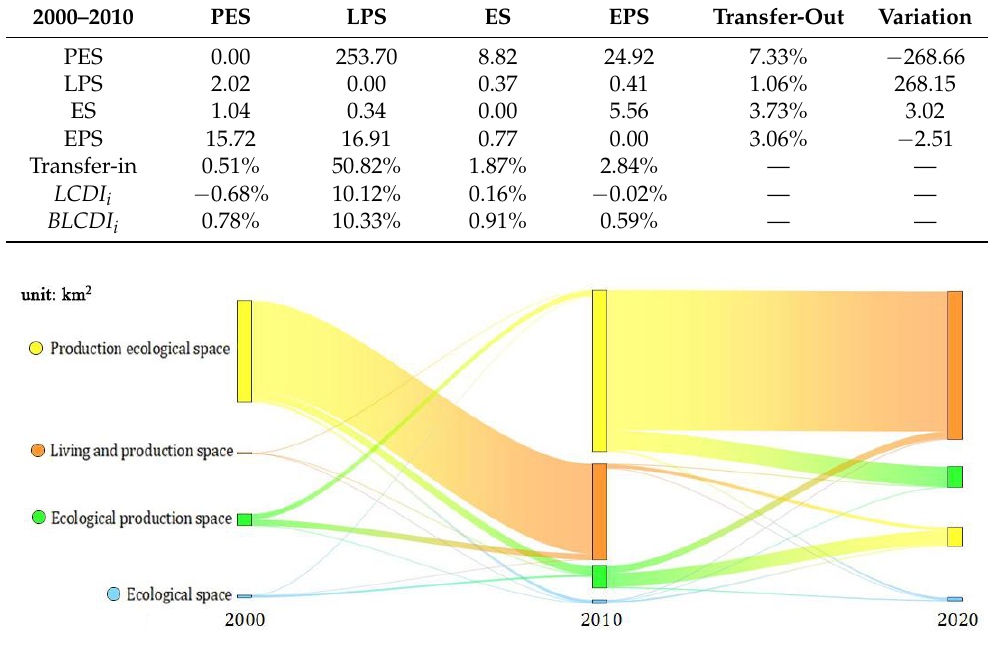
Figure 4. Sangji map of the PLES transfer from 2000 to 2020. Table 4. Spatial transfer matrix of the PLES in the study area from 2010 to 2020 (unit: km 2